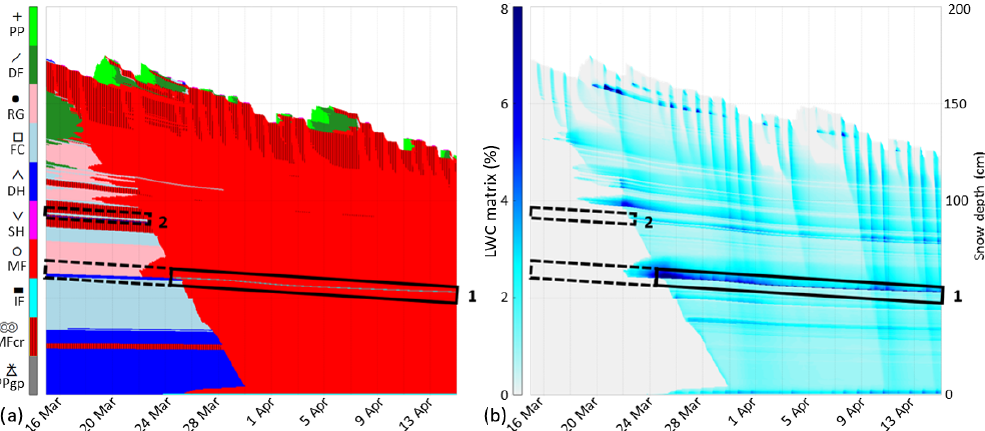
Figure 13. SNOWPACK simulation RE/PF/IceR from 15 March to 15 April 2017 at WFJ: (a) grain shape according to the classification of Fierz et al. (2009), and (b) liquid water content in the matrix domain. Rectangles highlight layers 1 and 2 with dashed lines before ice formation in the matrix domain and solid lines afterwards.